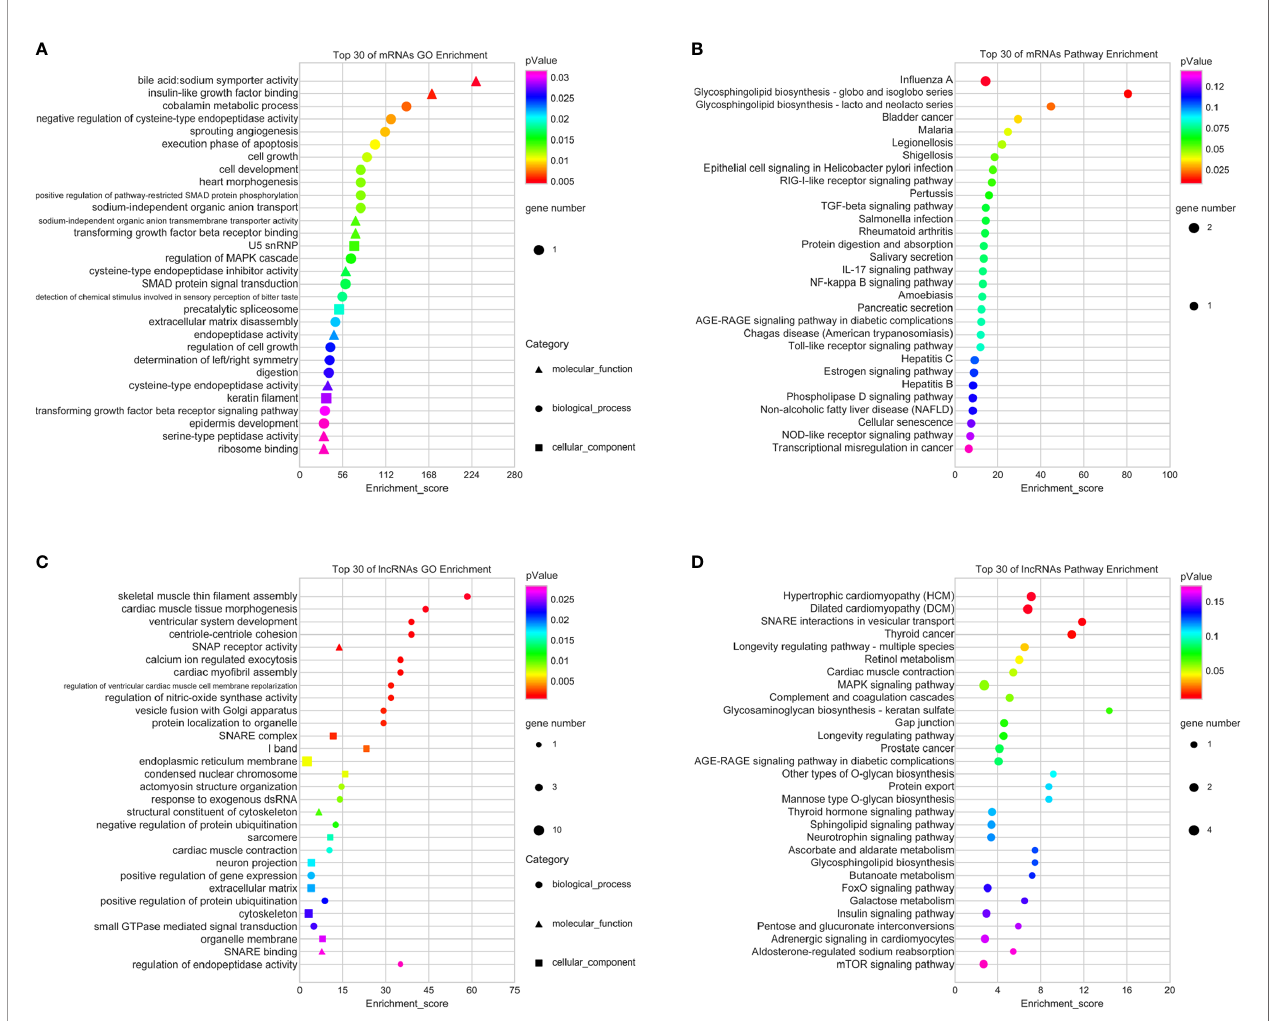
FIGURE 3 | GO and KEGG pathway analyses of upregulated mRNAs and lncRNAs. The top 30 of GO terms enriched in upregulated mRNAs (A) and lncRNAs (C) ; the top 30 of KEGG pathways enriched in upregulated mRNAs (B) and lncRNAs (D)